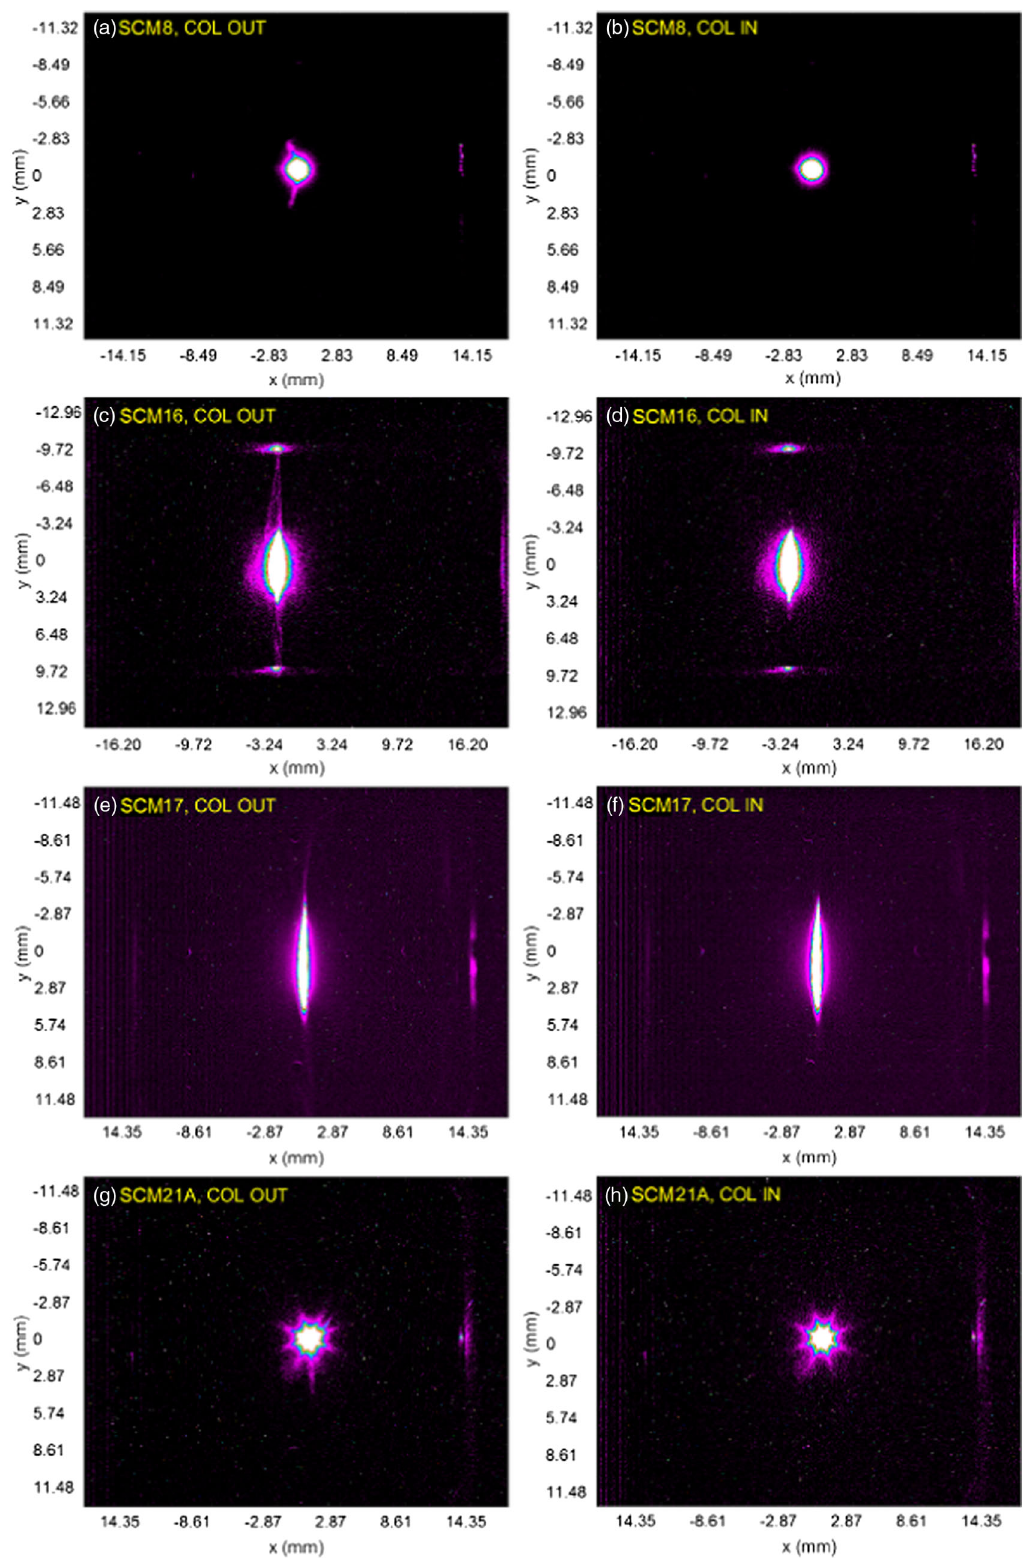
FIG. 5. Measured beam halo profiles at different beam line locations without (left) and with (right) collimation, respectively. (a),(b): Screen monitor SCM8 at the burst mode with gain 22 dB and integration time of 10 μ s. (c) – (h): screen monitors SCM16, 17, and 21A at the long pulse mode with gain 22 dB and integration time of 2 ms,